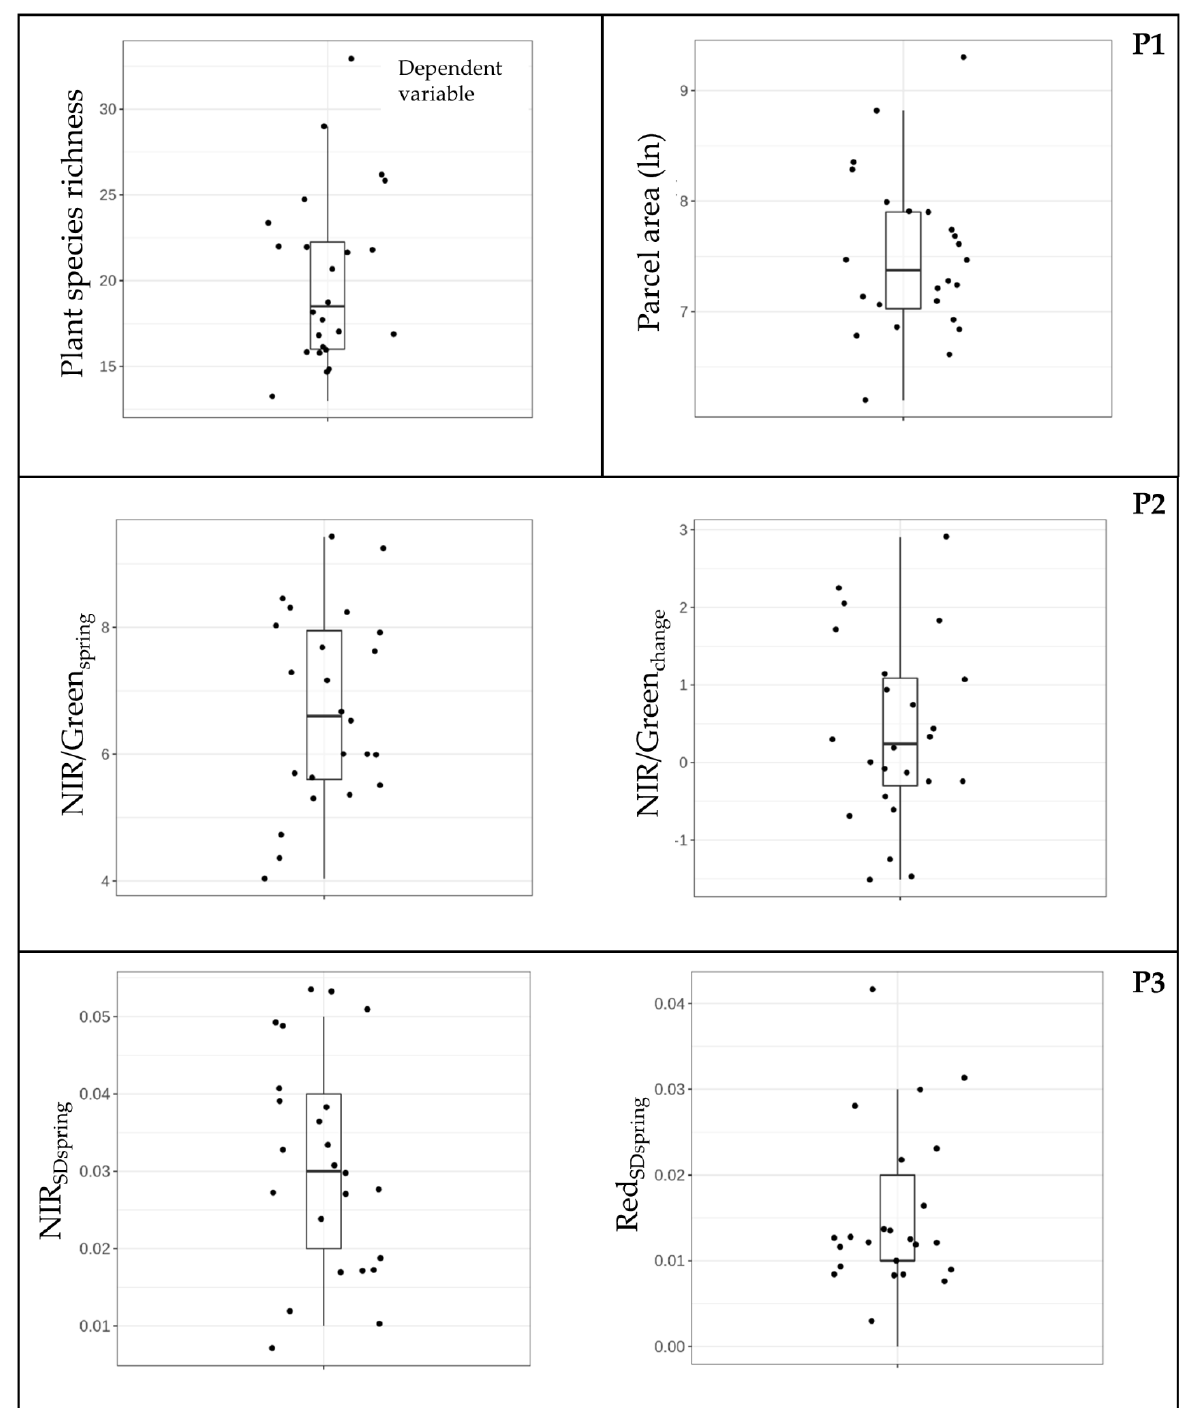
Figure 4. Summary statistics for the plant species richness in grassland parcels ( n = 24) and predictor variables included in the three spatial pathways (P1, P2, P3) established for the monitoring of vascular plant richness in grasslands parcels ( n = 24) of the Portuguese Peneda − Gerês mountain range. Species–area (P1) is represented by parcel area (ln), species–energy (P2) is represented by NIR/Green spring and its ratio of change between spring and summer (NIR/Green change ) and spe- cies − spectral heterogeneity (P3) is represented by standard deviation in the NIR (NIR SDspring ) and red band (Red SDspring ) in the spring Sentinel − 2 scene, variance spring and NIR variance summer. The most abundant species during the field survey are also shown.